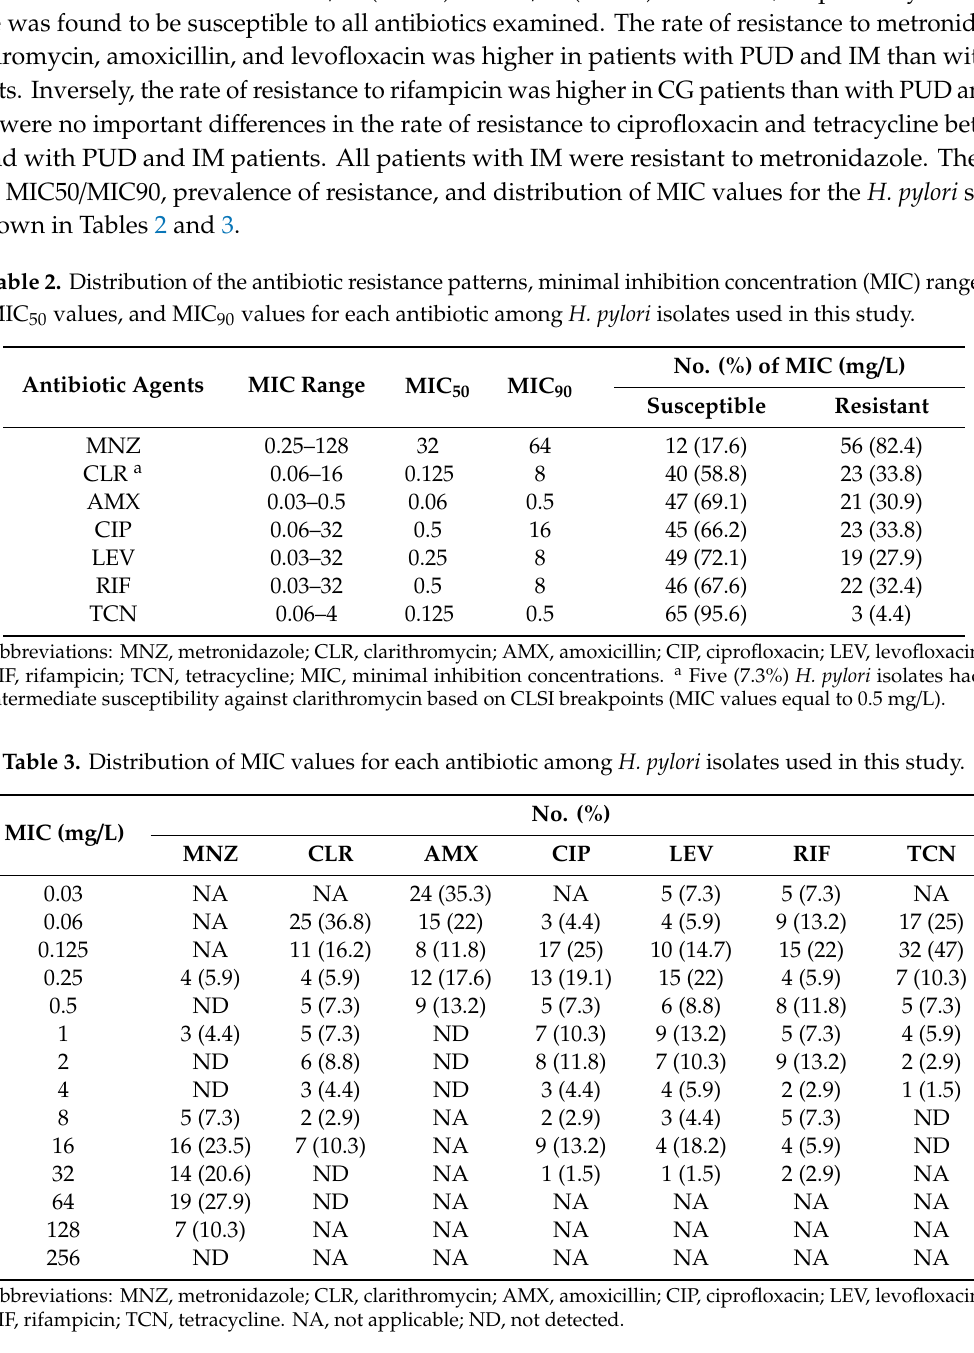
Table 2. Distribution of the antibiotic resistance patterns, minimal inhibition concentration (MIC) range, MIC 50 values, and MIC 90 values for each antibiotic among H. pylori isolates used in this study. Antibiotic Agents MIC Range MIC 50 MIC 90 MNZ 0.25–128